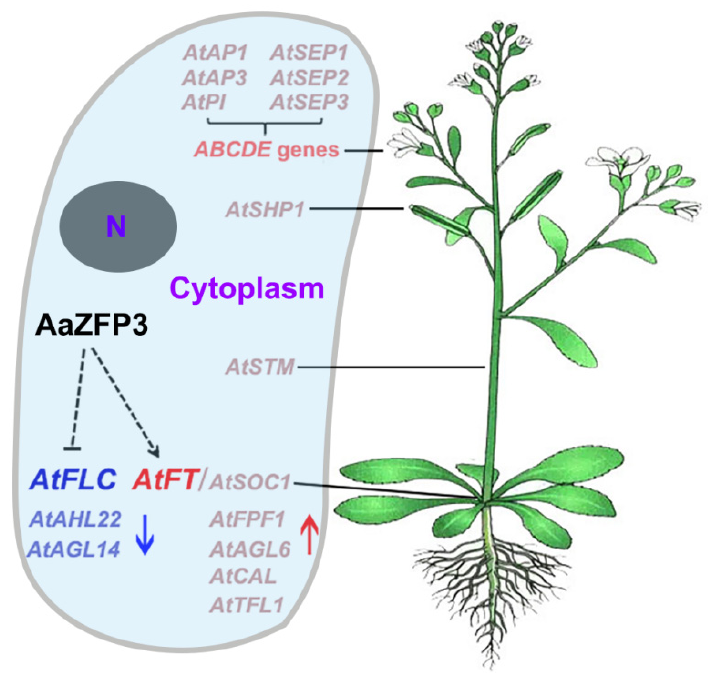
Figure 9. Proposed model of the genetic regulation of Arabidopsis flowering by AaZFP3 . Red (upward arrow), genes up-regulated following AaZFP3 overexpression; blue (downward arrow), genes down-regulated following AaZFP3 overexpression; N, nucleus. Detailed information on the gene names is provided in Supplementary Table S1.